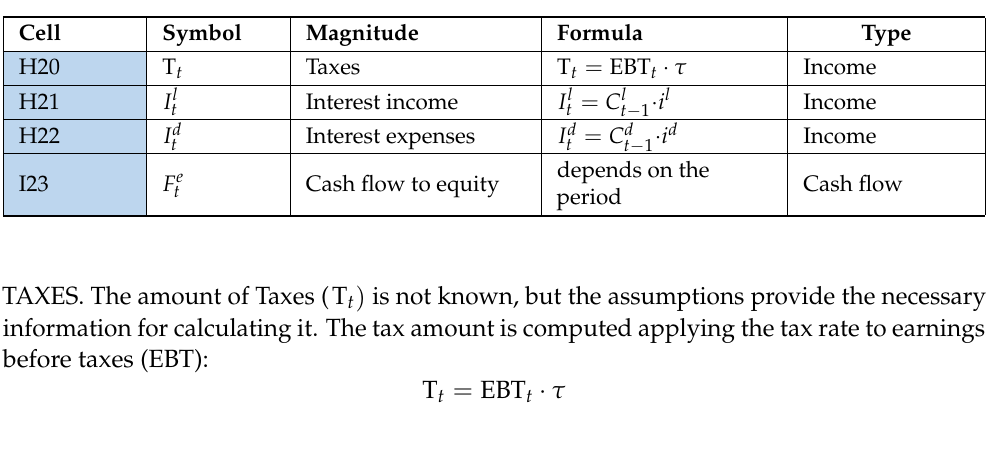
Figure 15. Cell I13 contains the law of motion for the cash receipts from customers (“SplitScreenStrip” sheet). (The cells whose values are provided in “PreCalc” are in yellow and the cells whose values are calculated with the law of motion are in green.)